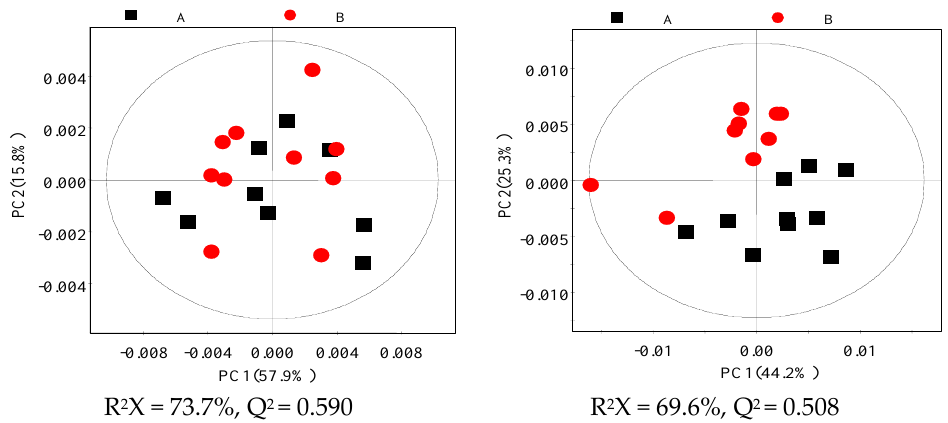
Figure 2. Principal Component Analysis (PCA) scores plot based on 1 H.NMR spectrum of aqueous phase acquired from the HS (heat stress) and TN treatments ( left ). PCA scores plot based on 1 H NMR spectra of plasma acquired from the HS and TN treatments ( right ). A = heat stress (HS) group; B = thermal neutral (TN) group.